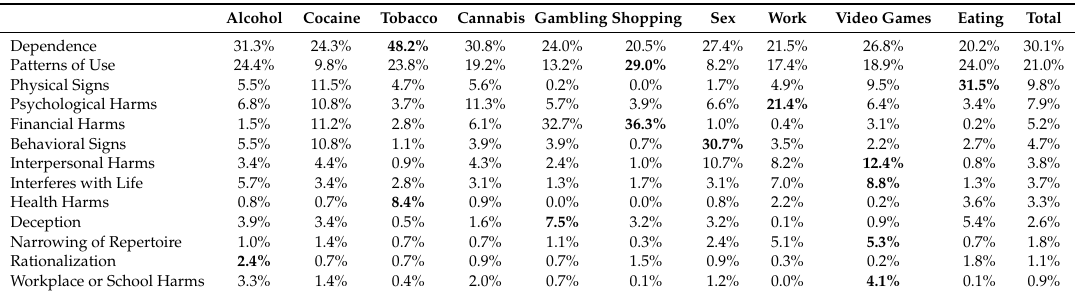
Table 3. Percentage of responses and di ff erences regarding the perceived most important indicators between the 10 addictive